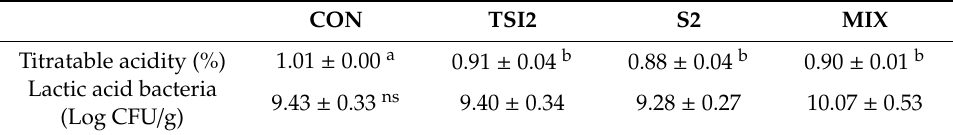
Table 4. Titratable acidity and lactic acid bacteria of each starter after 24-h stabilization. CON TSI2 Titratable acidity